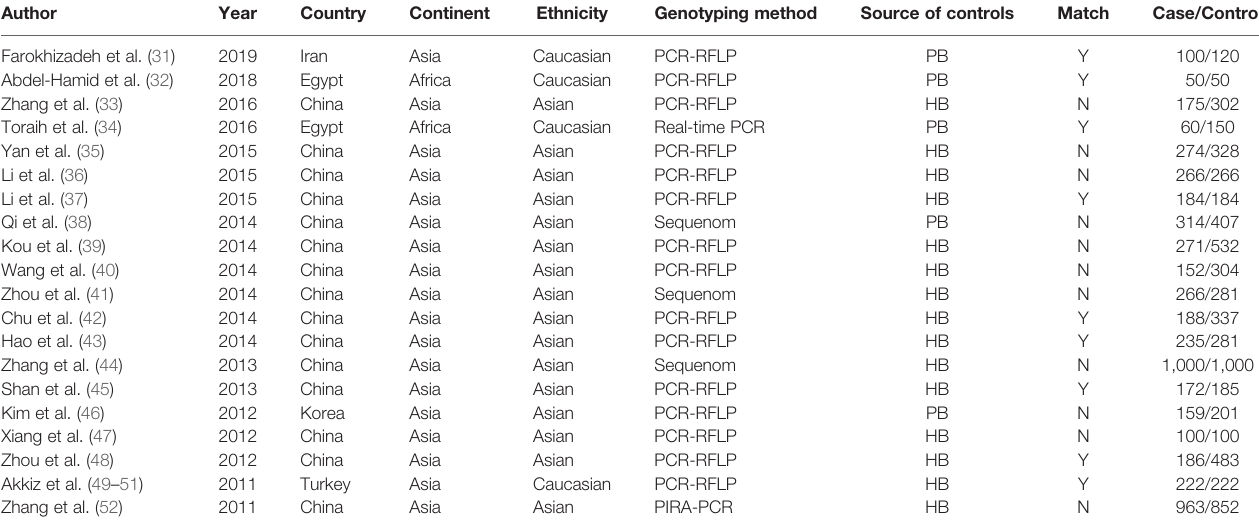
TABLE 1 | Main characteristics and methodological quality of eligible studies.